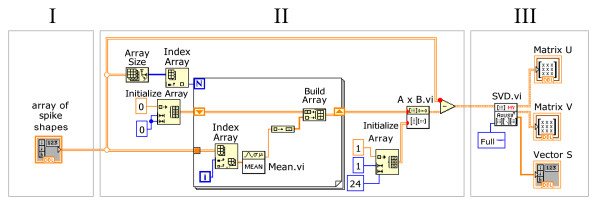
LabVIEW programme code for centering the X matrix across the 2ndmode and SVD procedure.I – X matrix containing spike shapes of the data set; II – centreing the matrix across the 2nd mode; III – SVD procedure and resulting matrices.